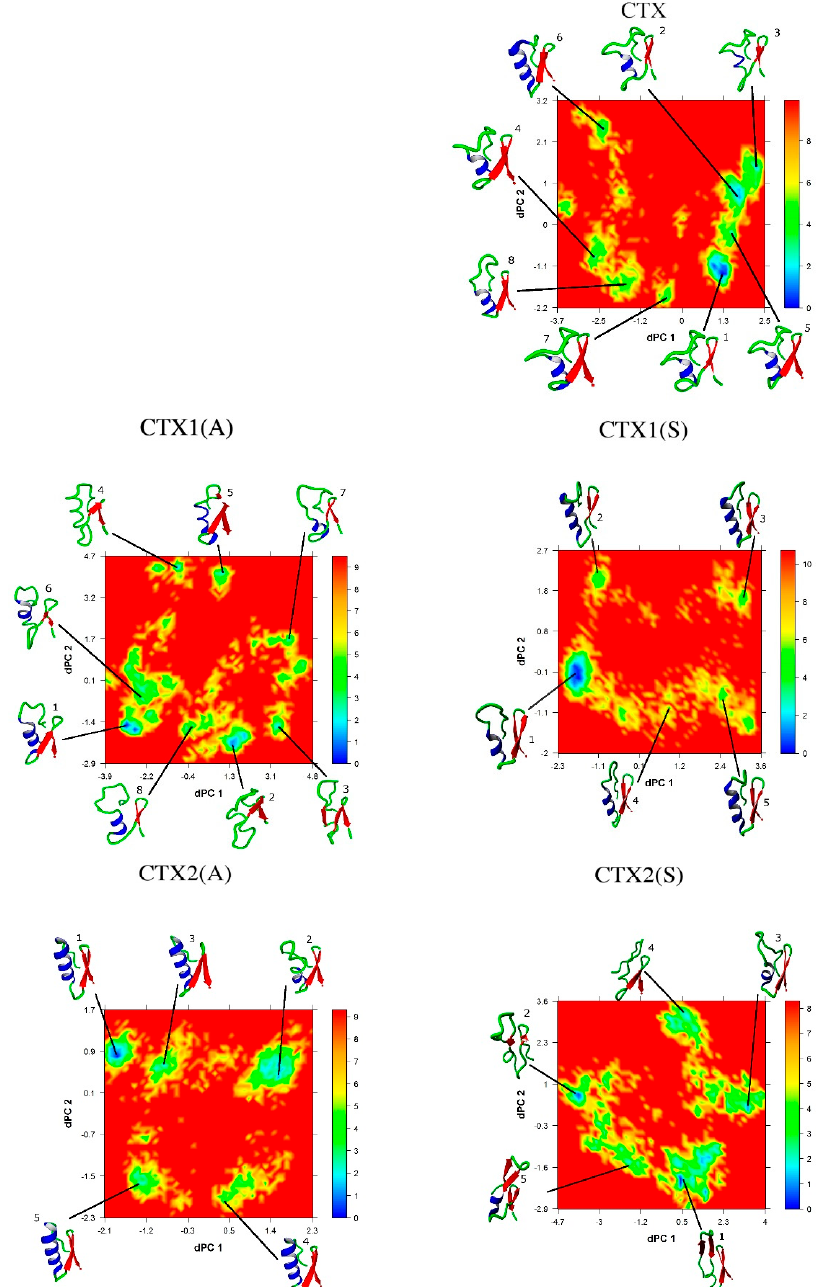
Figure 5. Figure 5. The free energy landscape (kJ · mol –1 ) as a function of the first two dihedral principal components (dPC1 and dPC2). The lowest energy conformations, as determined by cluster analysis, are shown and numbered in order from lowest to highest relative energy. The conformations have been rotated to optimally display the secondary structure elements and interactions. Secondary structure elements show as: red β -sheet, blue α -helix, and green turn/bend/coil.